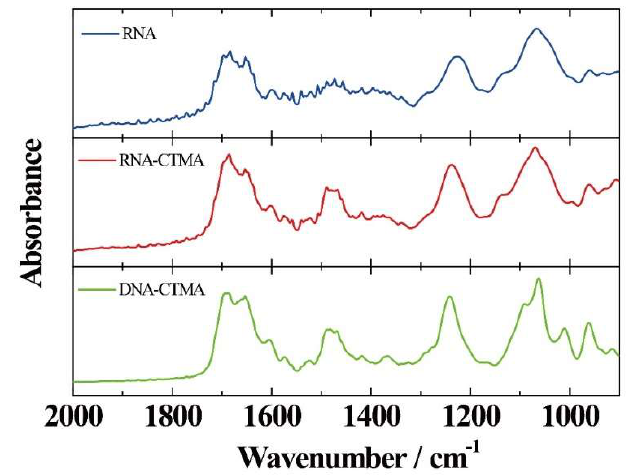
Figure 3. IR spectra of ( top ) RNA, ( middle ) RNA–CTMA, and (bottom ) DNA–CTMA films.